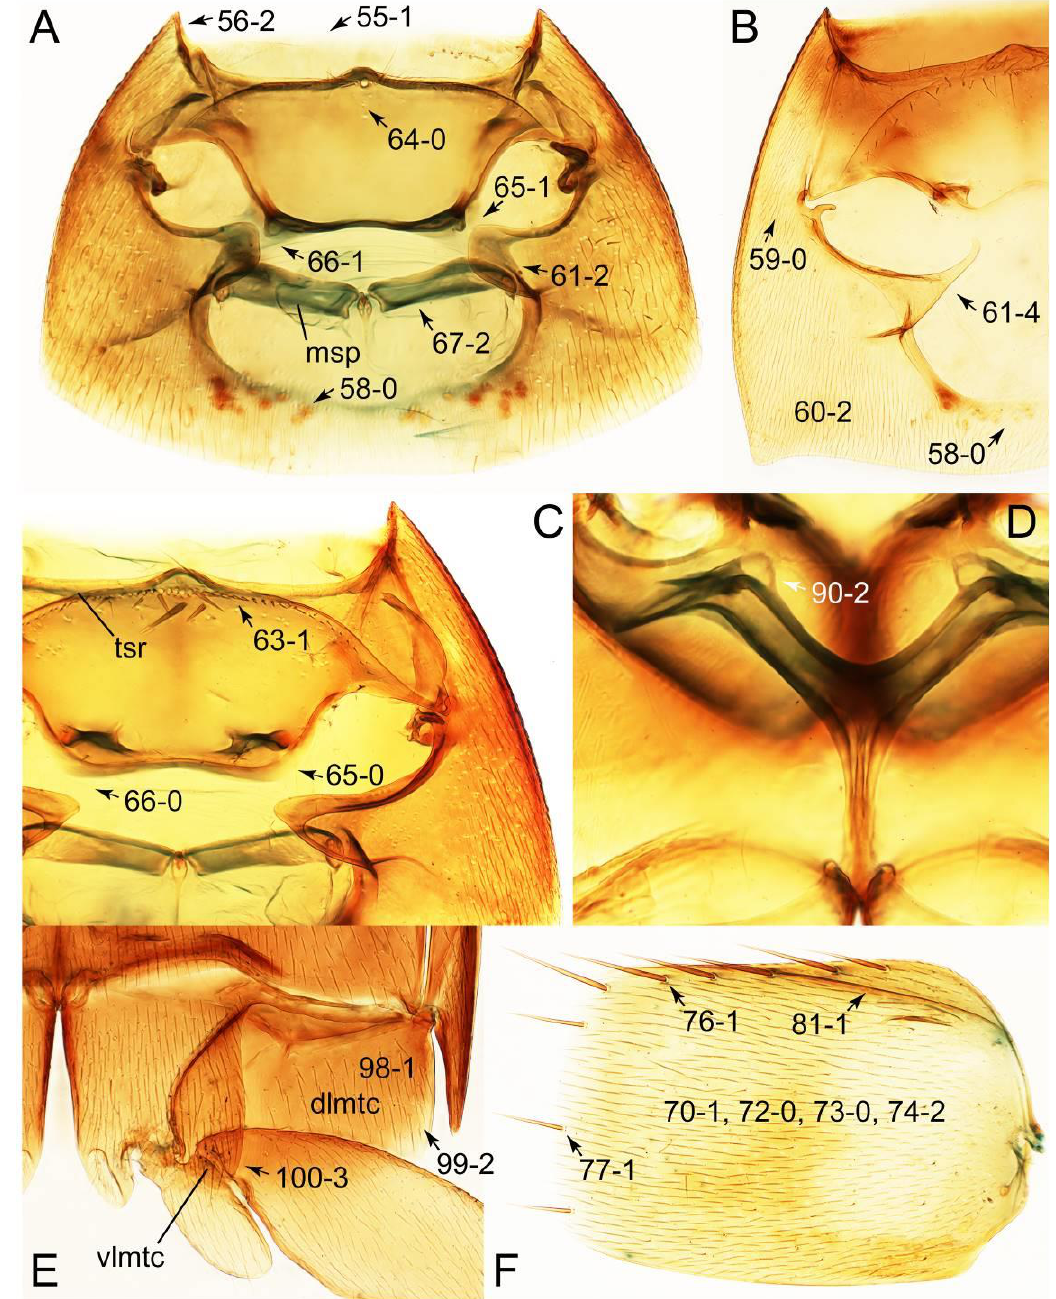
Figure 18. Photographs of body parts of Tachyporini: Euconosomatina, enlarged. ( A ) prosternum and pronotum of Sepedophilus scriptus , ventral view. ( B ), prosternum and pronotum of Sepedophilus littoreus , ventral view. ( C ) prosternum and pronotum of Sepedophilus cinctulus , ventral view. (D) metendosternite of Sepedophilus scriptus , dorsal view. ( E ) left metacoxa of Sepedophilus bisignatus , ventral view. ( F ) left elytron of Sepedophilus scriptus , dorsal view. Abbreviations: dlmtc, dorsal lamella of metacoxa; msp, mesospiracular peritremes; tsr, transverse sternacoxal ridge of prosternum; vlmtc, ventral lamella of metacoxa. Characters and character states (format X-X) are indicated on each